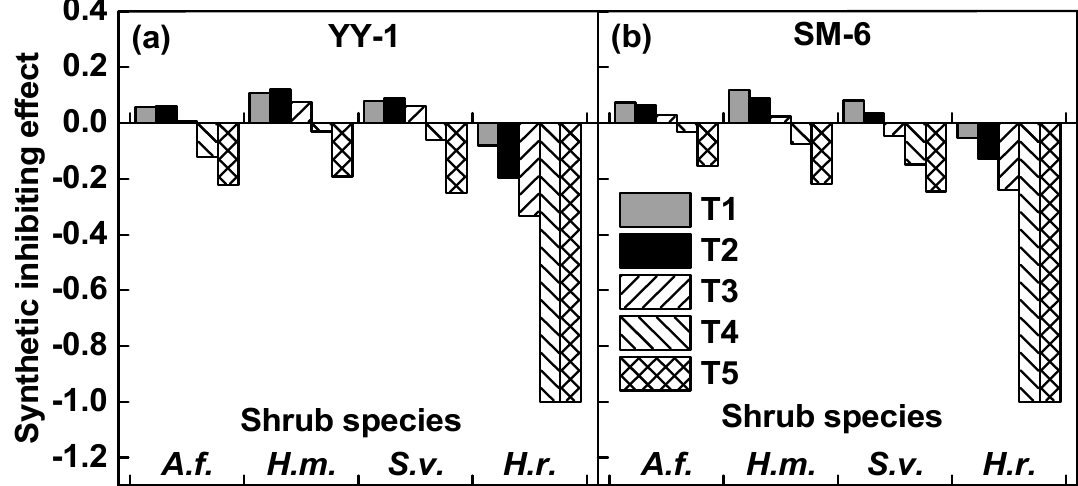
Figure 5. Synthetic inhibiting effect of the aqueous leaf extracts from the donor species on the target A. pedunculata species. The synthetic inhibiting effect (SE) value was calculated as the average allelopathy index ( RI ) value of all indicators of each treatment of the target A. pedunculata species of YY-1 ( a ) and SM-6 ( b ). The concentrations of 0 (CK), 0.025 (T1), 0.05 (T2), 0.1 (T3), 0.15 (T4), and 0.2 g · mL − 1 (T5) of aqueous leaf extracts from the donor species— Amorpha fruticosa ( A.f. ), Hedysarum mongolicum ( H.m. ), Sabina vulgaris ( S.v. ), and Hippophae rhamnoides ( H.r. ).